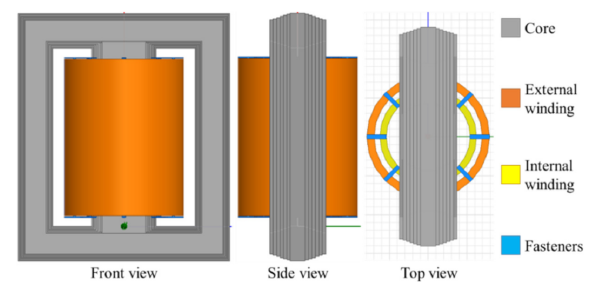
Figure 7. Computational model of the transformer used in